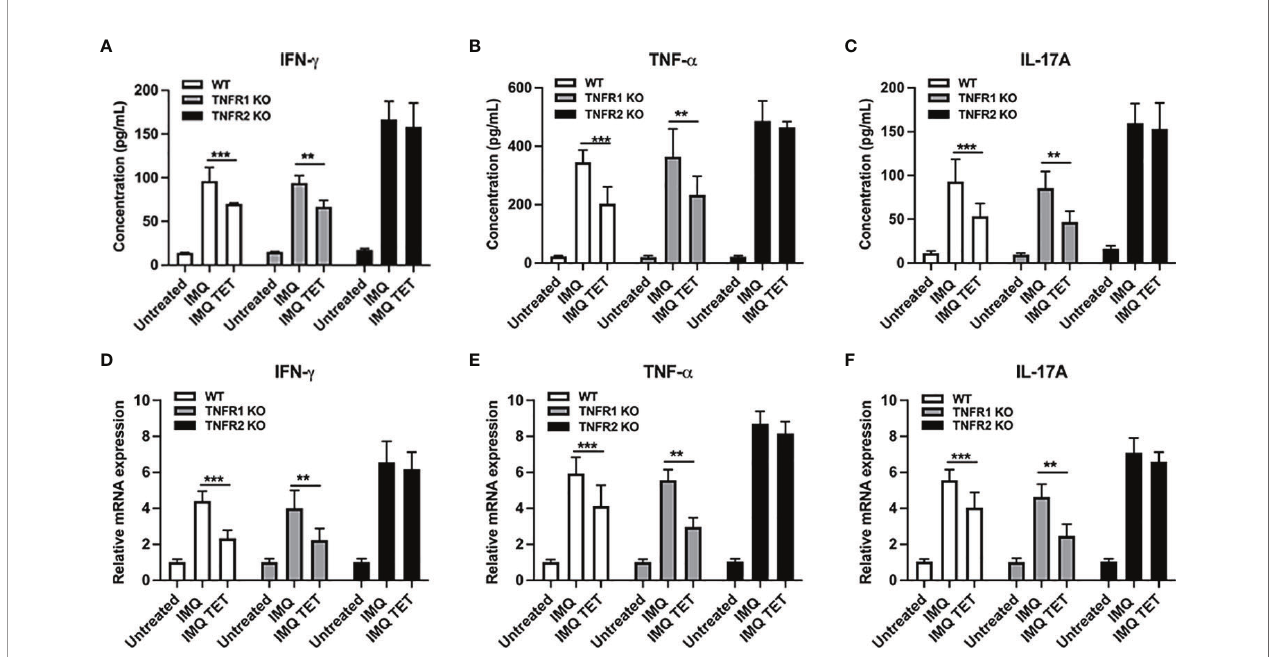
FIGURE 7 | TET NE suppresses mRNA and protein expressions of pro-in fl ammatory cytokines in TNFR2 dependent manner. WT, or TNFR1 -/- or TNFR2 -/- mice (N = 9) were treated with IMQ for 6 days; TET NE treatment starts from the second day after IMQ treatment for 5 days. 24 hours later, the mice were sacri fi ced. Skin lesion samples were rapidly frozen in liquid nitrogen and stored at -80°C. The protein level of IFN- g (A) , TNF (B) , and IL-17A (C) in serum were measured by CBA kits. The mRNA expression of IFN- g (D) , TNF (E) , and IL-17A (F) in skin lesions was measured by RT-PCR. Data were shown as means ± SEM. ** P < 0.01, *** P < 0.001, compared with IMQ